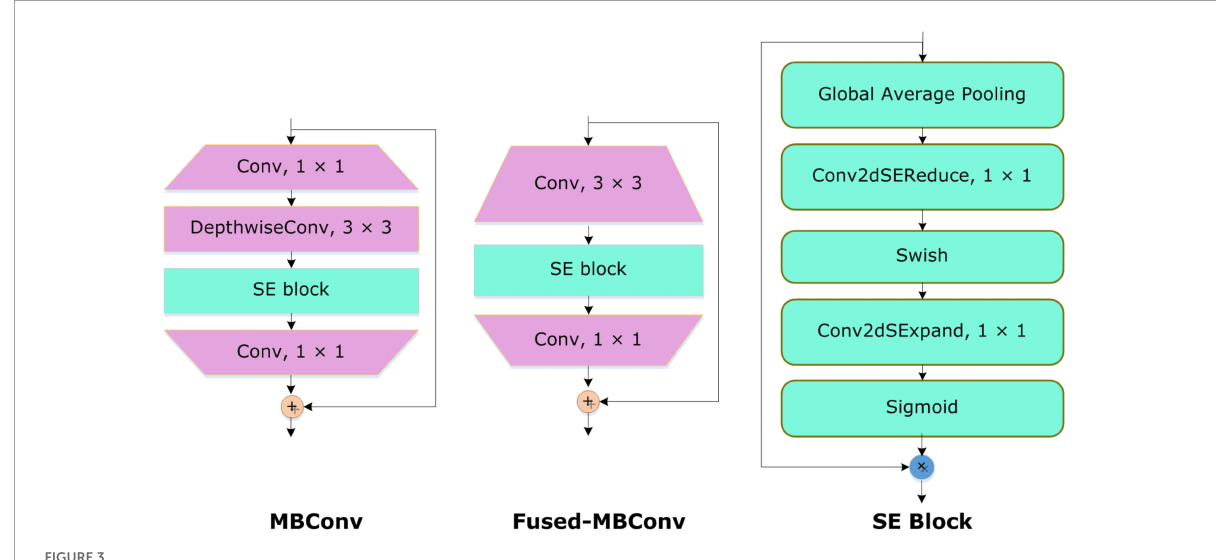
FIGURE3 Visual demonstration of MBConv4, Fused-MBConv4, and SE blocks.